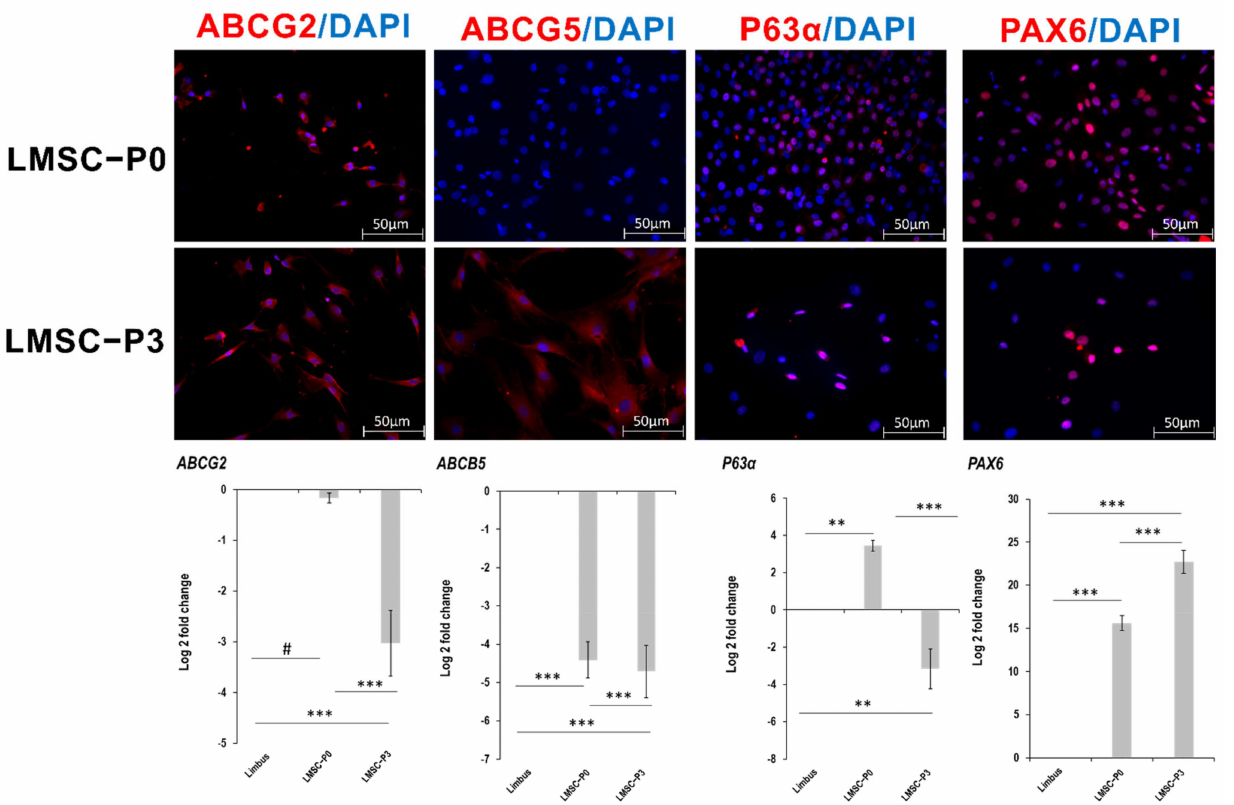
Figure 2. Expression of the stem cell and ocular biomarkers in limbal stem cells. Panel of the representative images of the limbal stem cells showing positive expression of ABCG2, ABCB5, P63- α , and PAX6 (red) in both epithelial (LMSC − P0) and stromal cell (LMSC − P3) populations, counterstained with DAPI (blue). Scale: 50 µ m. Level of expression (lower panel) of ABCG2 , ABCB5 , P63 α , and PAX6 genes quantified using qRT-PCR in limbal epithelial (LMSC − P0) and stromal (LMSC − P3) cells, relative to native limbal tissue ( n = 5). P63 α was found to be down-regulated in LMSC − P3 where all the other stem cell genes ABCG2 , ABCB5 and PAX6 were found to follow same pattern of expression in both early and late passages of the culture. The results were plotted as mean log 2-fold change ± SD. The statistical analysis was performed using Kruskal–Wallis one-way ANOVA test. # p > 0.05, ** p < 0.01, *** p <